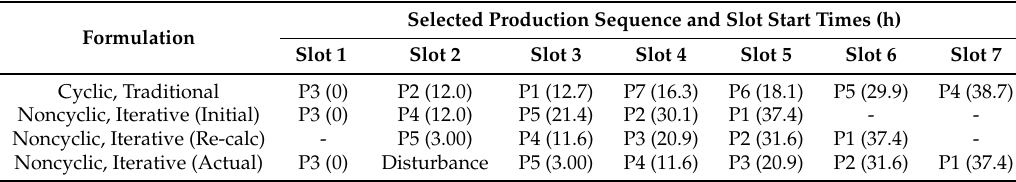
Table 21. Production schedule: Scenario 3.